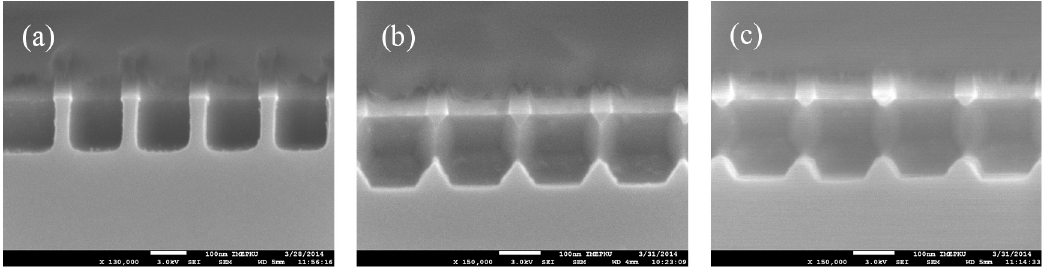
Figure 6. 35 °C, 25% TMAH solution is used to etch a silicon Fin with a 50 nm width. The SEM images obtained after different etching times ( a – c ): 0 s/20 s/30 s.